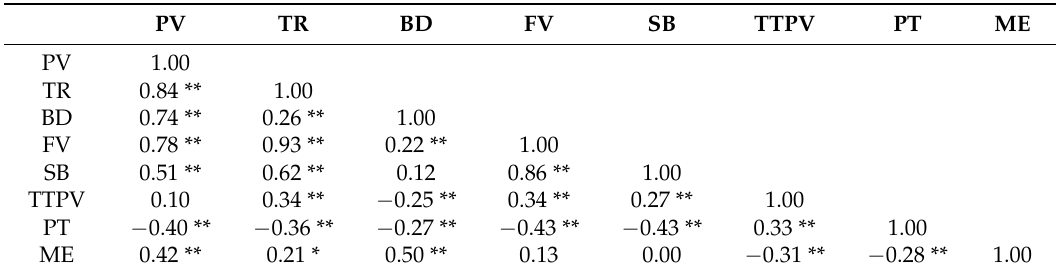
Table 4. Correlations between pasting properties and malt